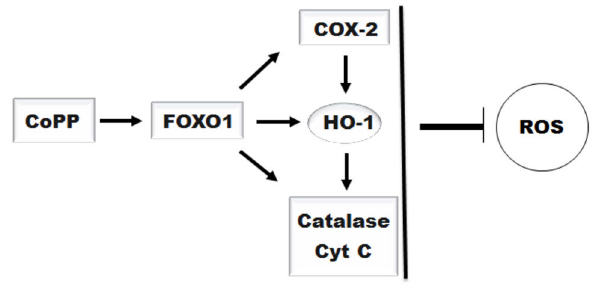
Figure 7. The scheme of CoPP regulates mitochondrial- derived ROS production mediated by